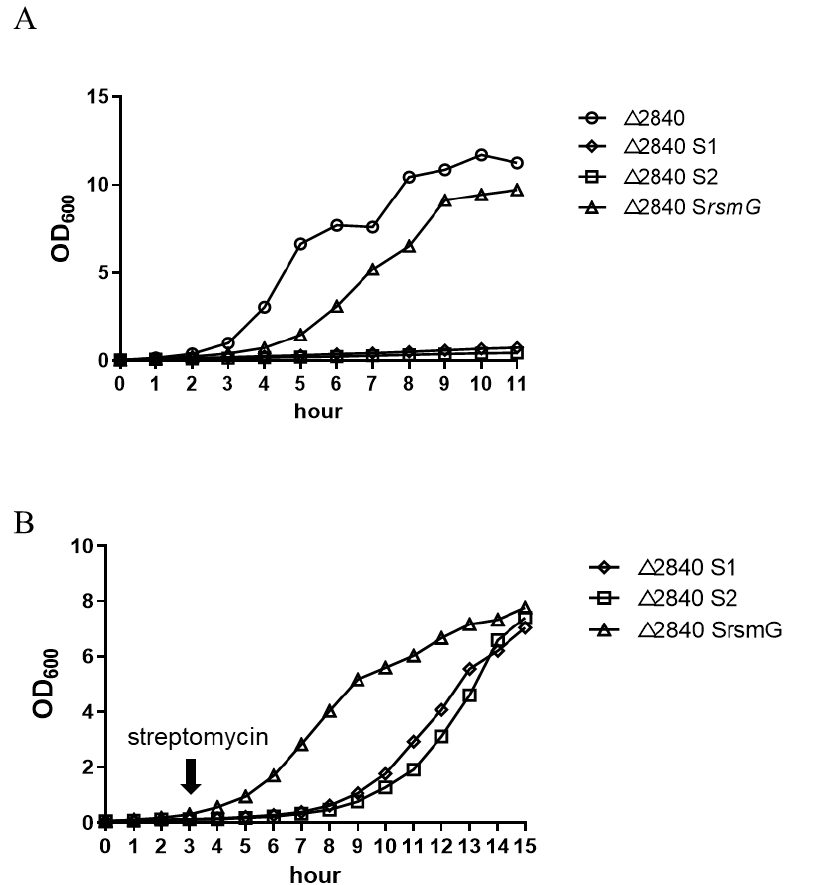
Figure 2. Comparison of growth profiles among ∆ dgeo _2840 parent and three Sm-resistant mutant strains ( A ) in antibiotic-free TGY medium and the SmD phenotype of ∆ dgeo _2840 S1 and S2. The arrow indicates the point at which 50 µg/mL streptomycin was added ( B ).